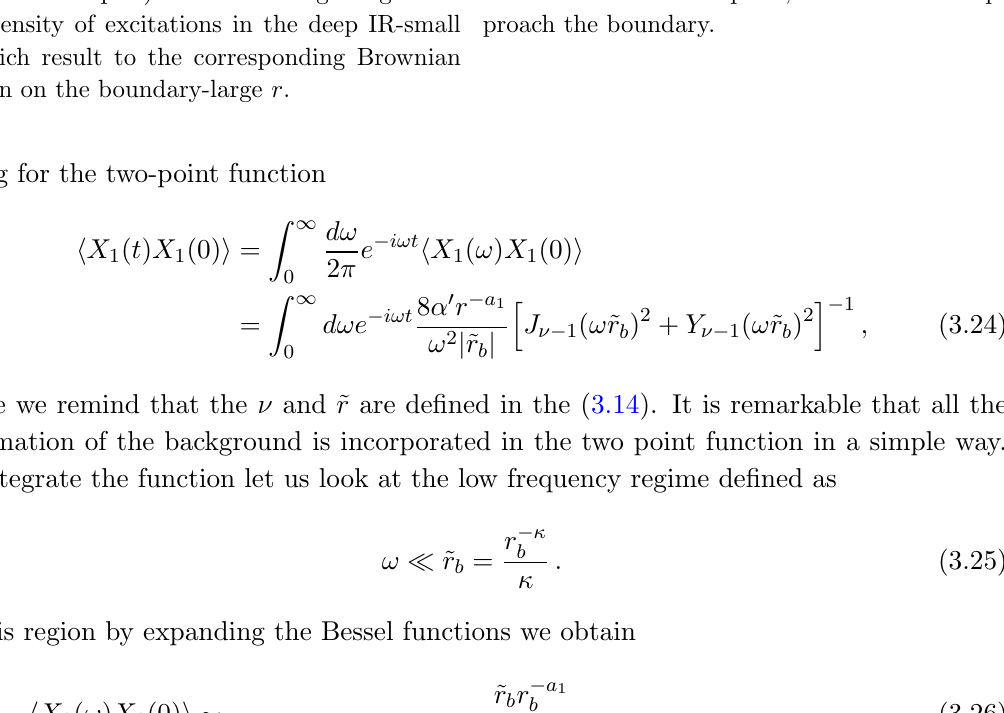
Figure 2 . The real part of the (cid:13)uctuations a (cid:12)xed frequency, time and scalings of the back- ground. The large magnitude and frequency of excitations in the deep IR, weaken as we ap- proach the